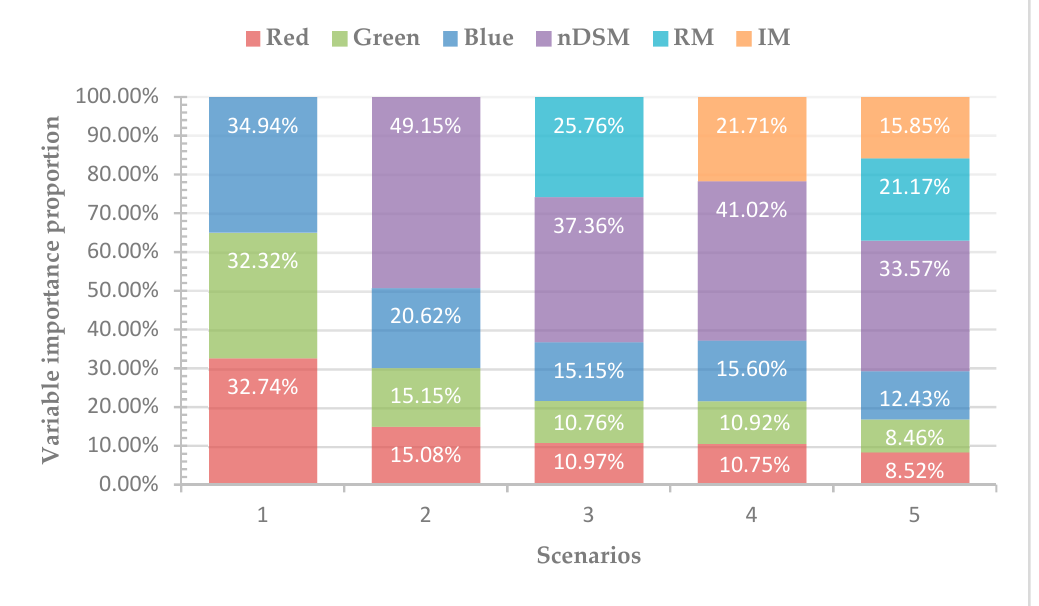
Figure 12. Variable importance from mean decrease impurity method in five scenarios in term of proportion.